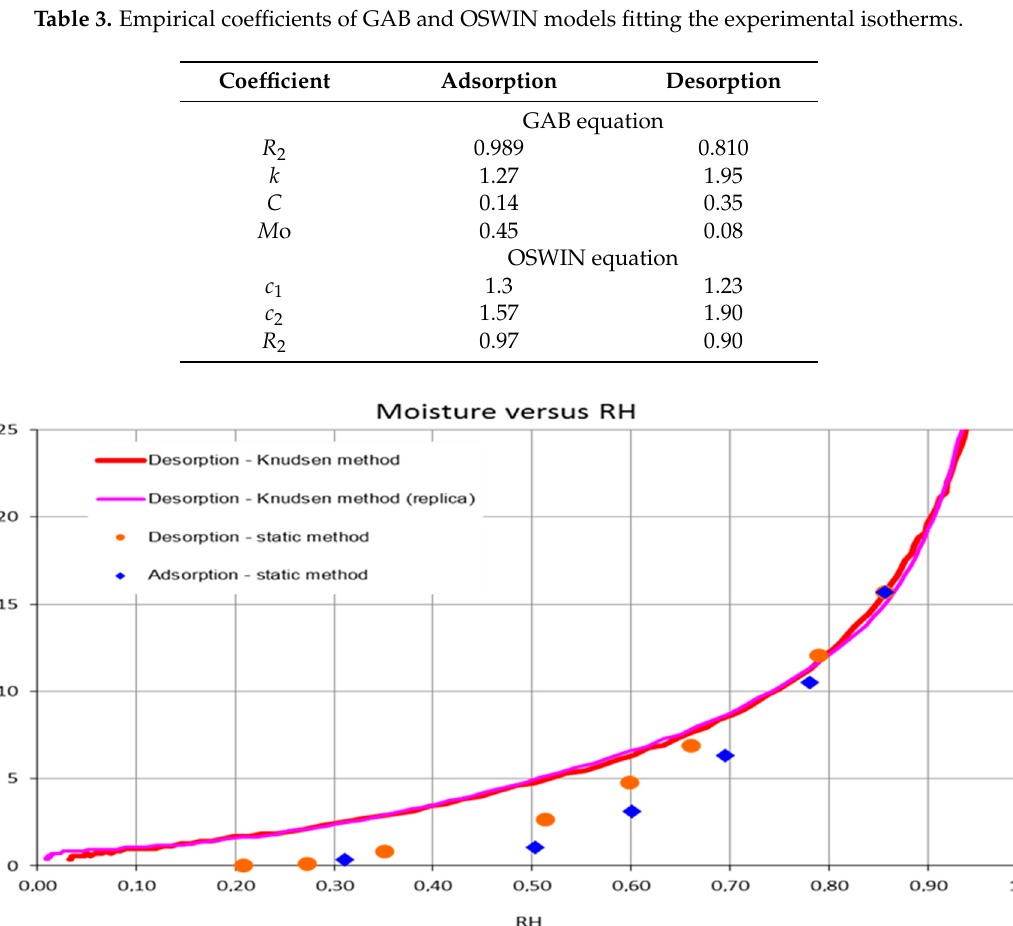
Table 3. Empirical coefficients of GAB and OSWIN models fitting the experimental isotherms.